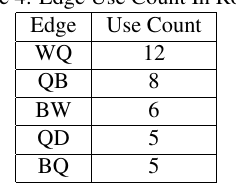
Table 4: Edge Use Count In Routes